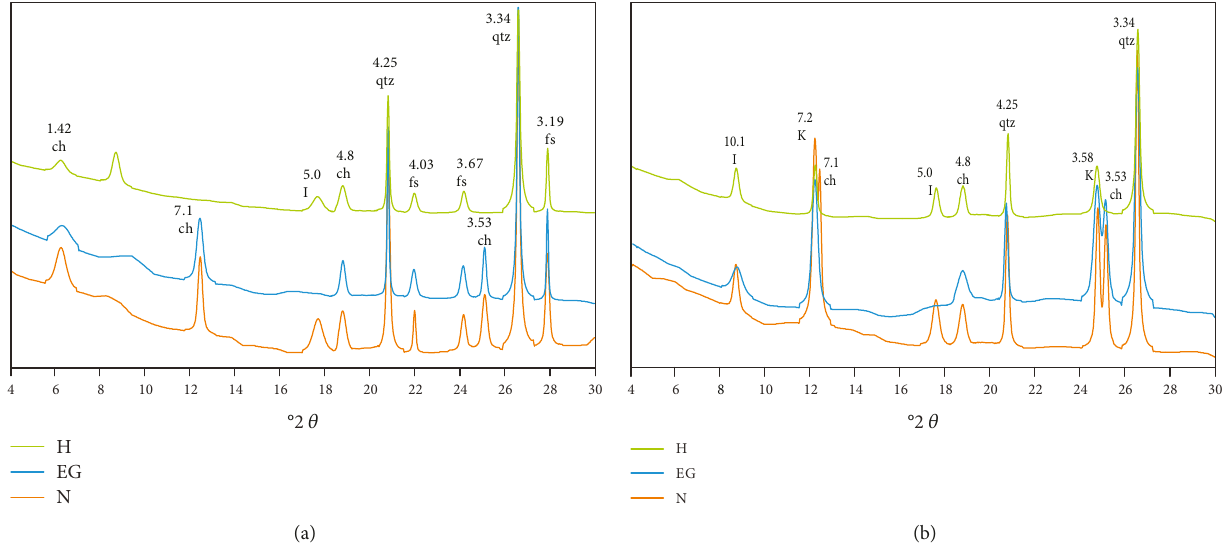
Figure 5: X-ray di ff raction analysis (XRD) of the < 2 μ m fraction for clay mineral identi fi cation. qtz=quartz; fs=alkali feldspar; ch=chlorite; I=illite; K =kaolinite (N, EG, and H represent samples treated with air-dried ethylene glycol and heated at 500 ° C). (a) SD24-55 and 2798.74m; (b) Z10, 3108.926